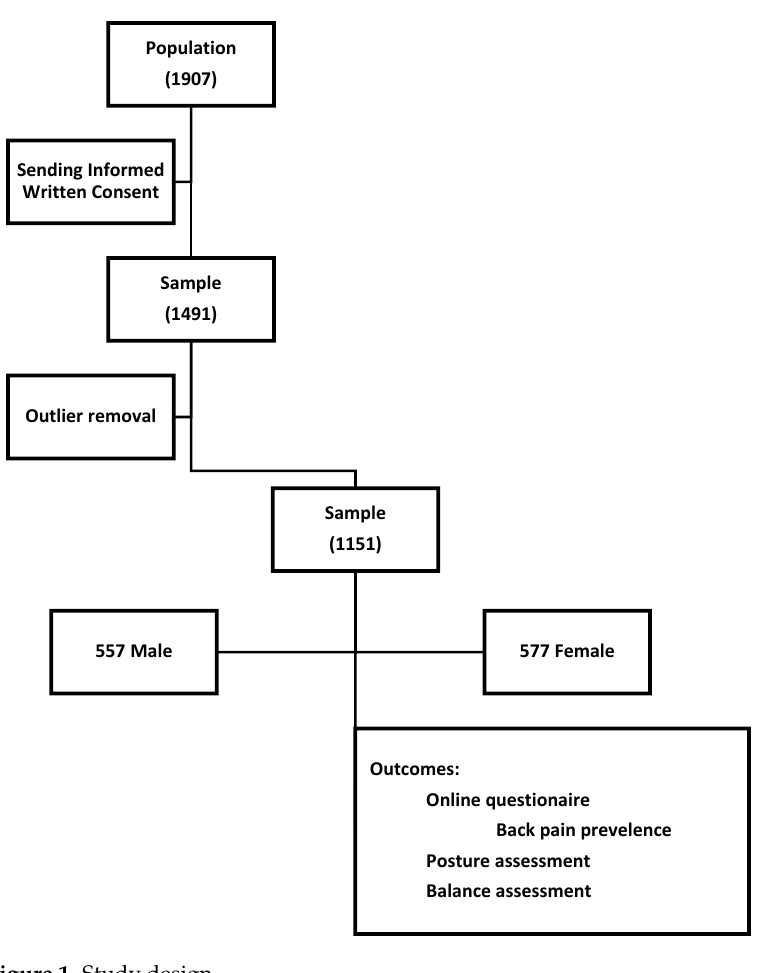
Figure 1. Study design.